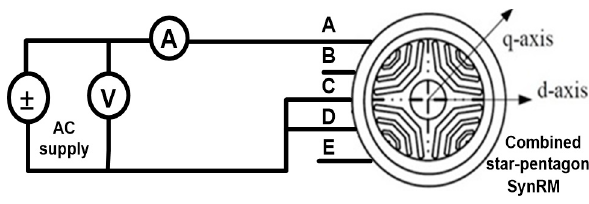
11 of 18 Figure 10. Simulated performance of the five-phase combined star-pentagon SynRM at rated torque